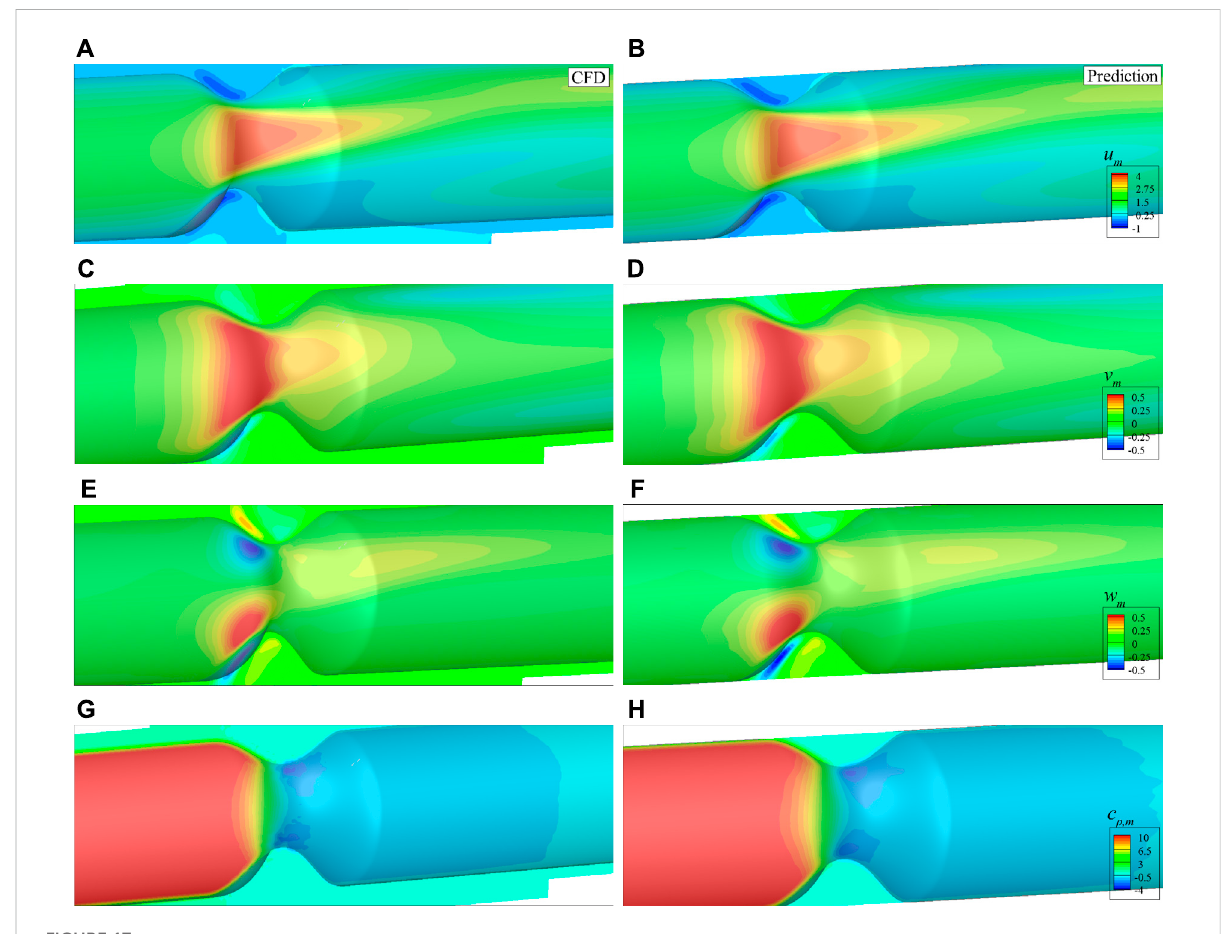
FIGURE 17 Comparisonofthemeanvelocitiesandpressurewithasymmetricstenosisontheplaneof z =0: (A) u m byCFD, (B) u m byDNNprediction, (C) v m by CFD, (D) v m by DNN prediction, (E) w m by CFD, (F) w m by DNN prediction, (G) c p , m by CFD, (H) c p , m by DNN prediction.